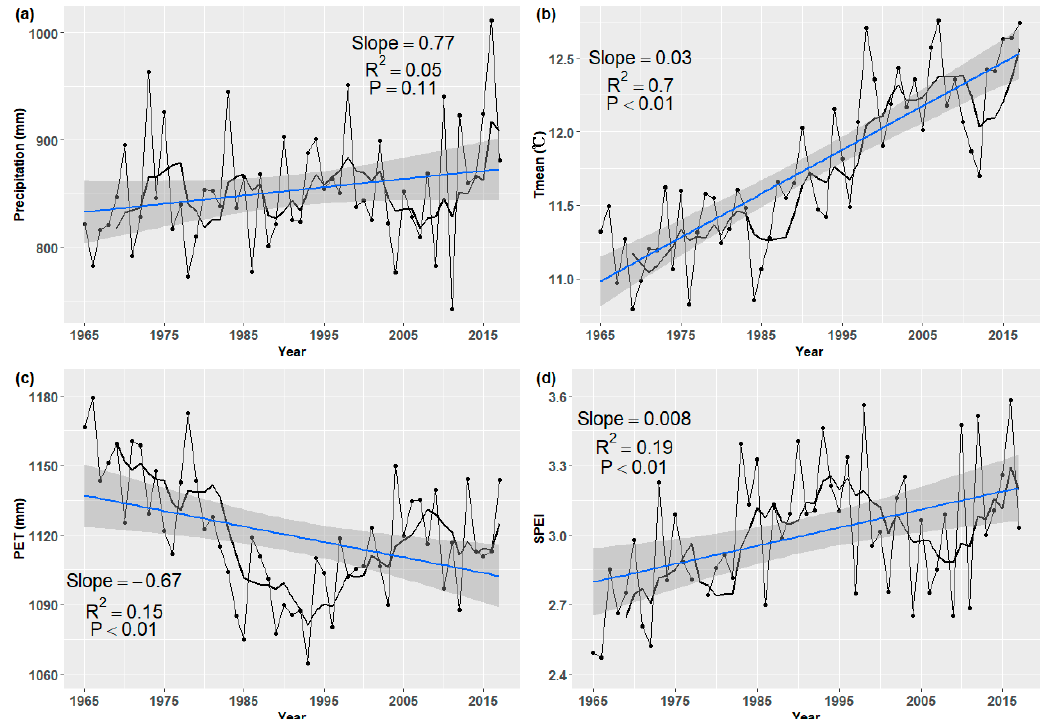
Figure 2. Annual variation of average ( a ) precipitation, ( b ) mean air temperature ( T mean ), ( c ) potential evapotranspiration (PET), and ( d ) standardized precipitation evapotranspiration index (SPEI) of China from 1965 to 2017. The bold black line shows the 5-year moving average value. The blue line shows the trend lines at a 95% confidence interval. p indicated that the significance levels ( p < 0.01 indicated the significant level of 0.01).